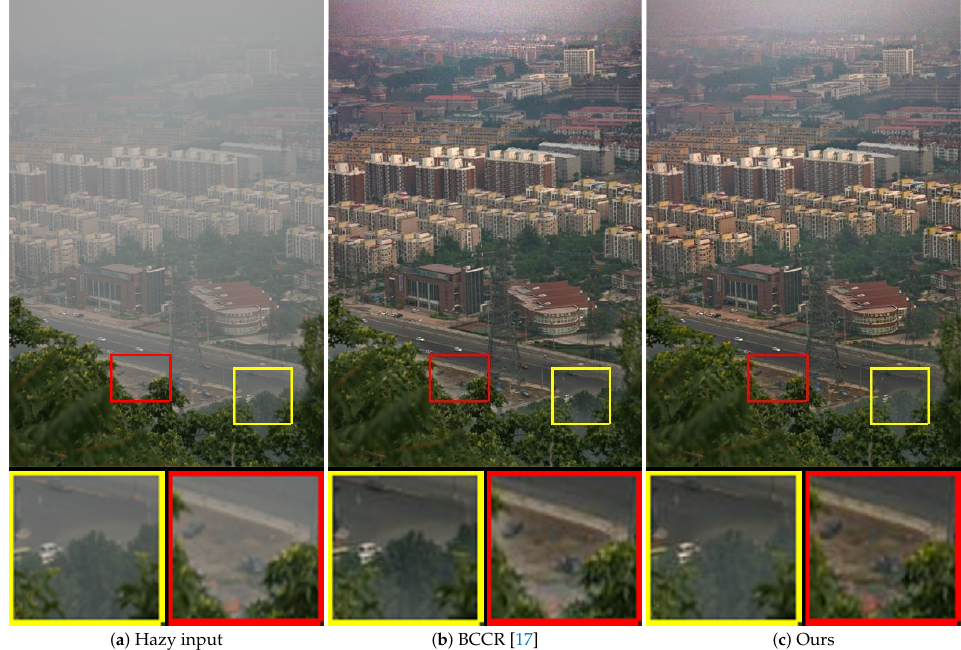
Figure 11. The dehazing result of the proposed method and state-of-the art methods on the real hazy images. The proposed method generates much clearer images with clearer structures and